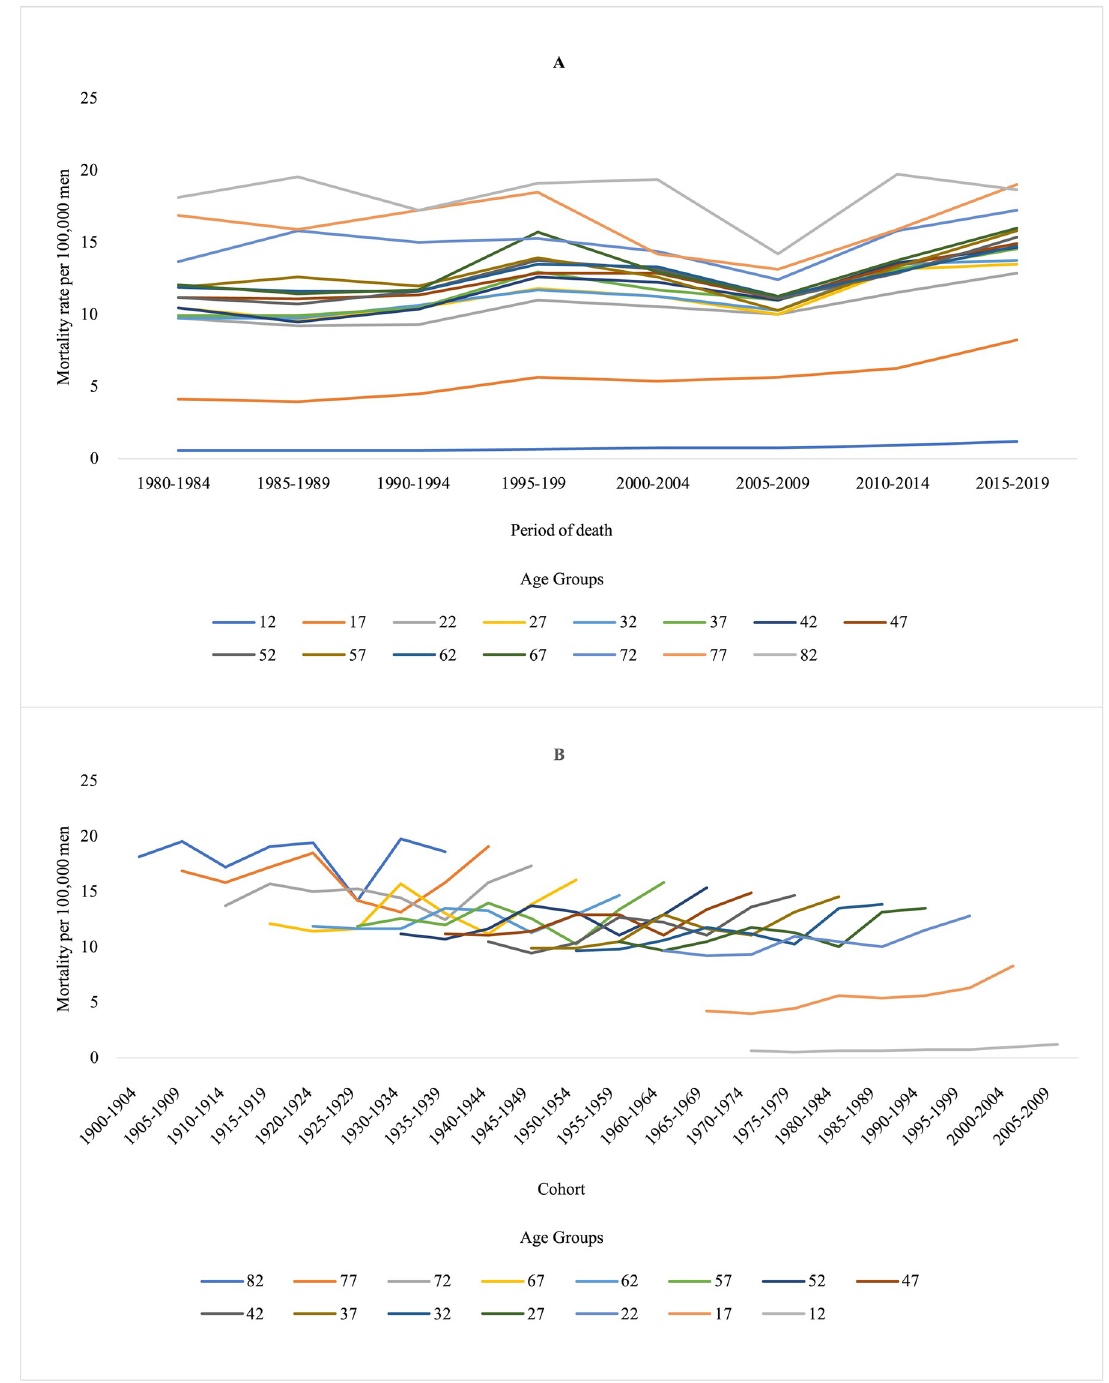
Fig 1. Total Suicide mortality rates per 100,000 men in Brazil, according to age group, period, and cohort, from 1980 to 2019.